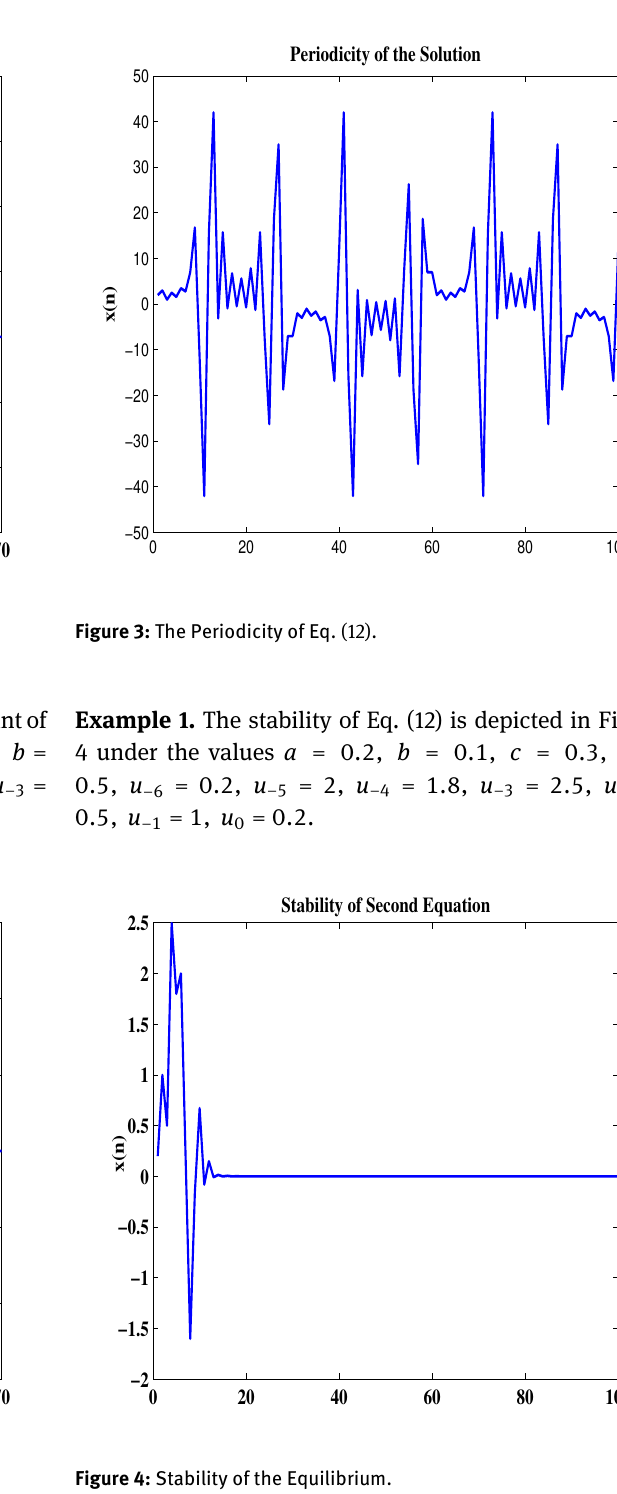
Figure 2: Global Behaviour about the Equilibrium.